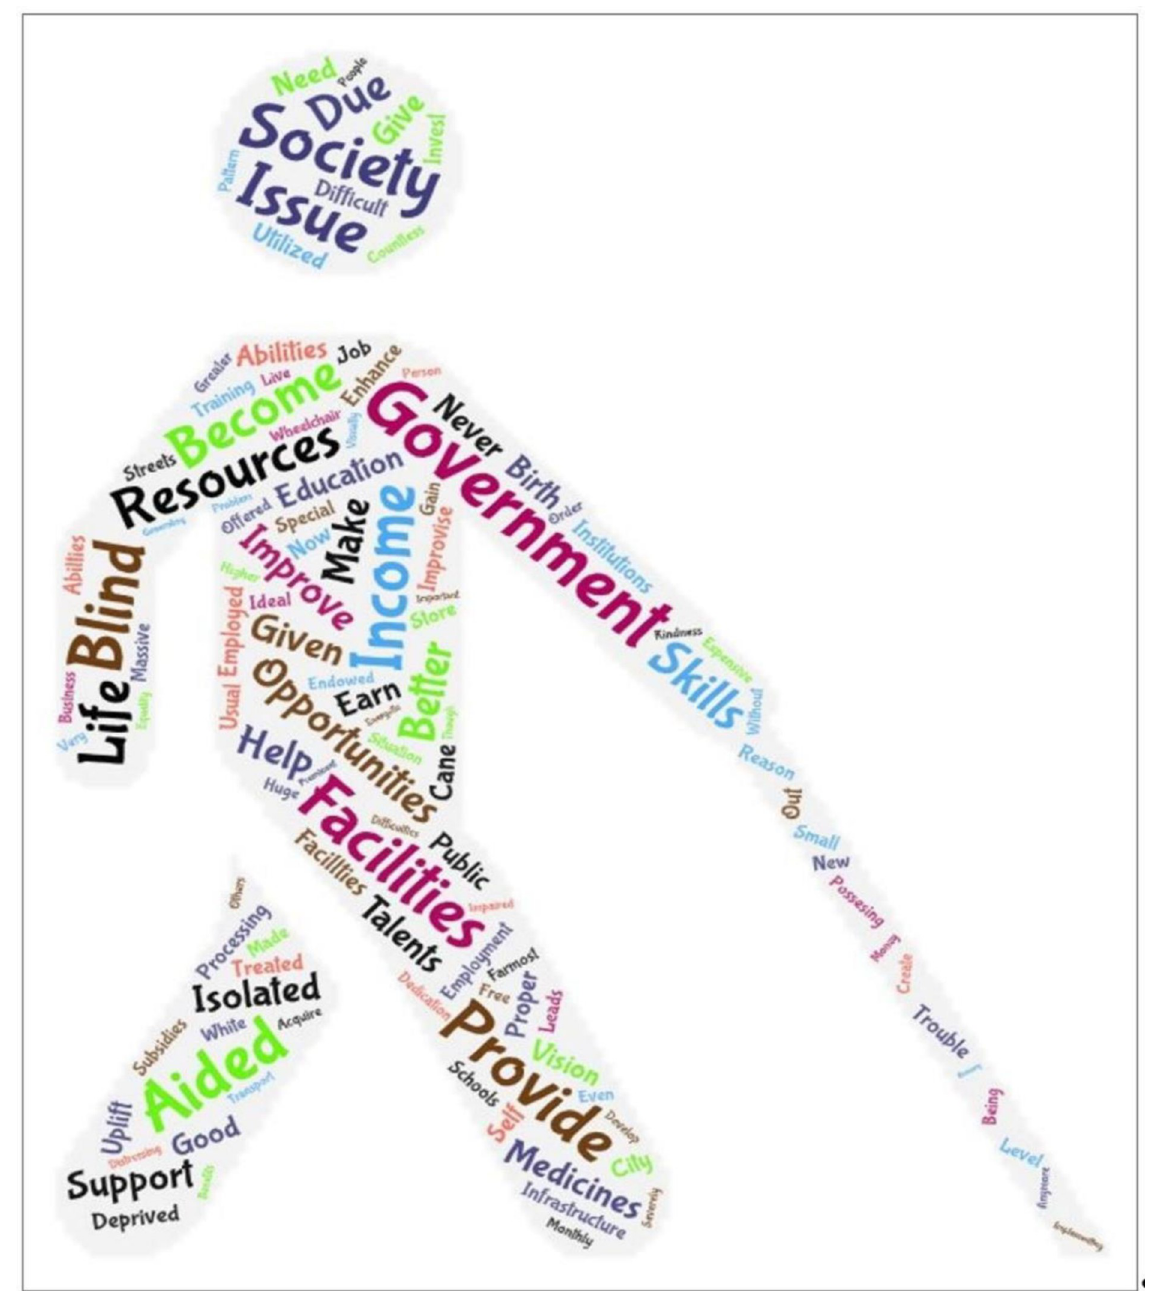
Fig 2. WordCloud illustration. Source: Authors’ illustration based on qualitative